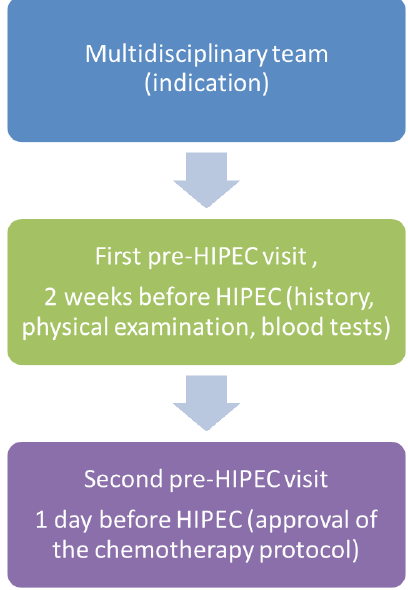
Fig. 1. Scheme of pre-HIPEC preparation of